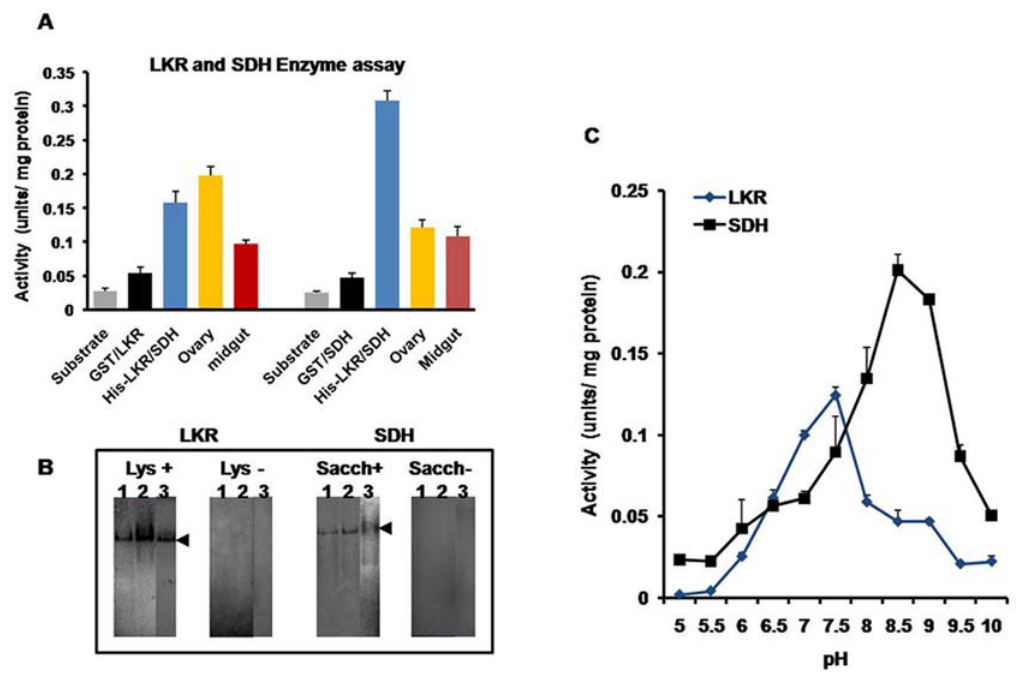
Figure 4. Enzymatic activity assay. A. Native and recombinant proteins were analyzed for LKR and SDH activities under conditions of excess concentrations of all LKR substrates or all SDH substrates, respectively. Data are presented as units/mg protein. Mean 6 S.D (n=3). B. Separation of LKR and SDH activities by native-PAGE gel electrophoresis. Samples of partially purified midgut and ovaries, and recombinant His-LKR/SDH were separated by native PAGE and subsequently stained for SDH and LKR activity. In the control gel, samples incubated without L-lysine and saccharopine are labeled ‘‘Lys-’’ and ‘‘Sacch-’’. In the LKR and SDH activity staining gel, the samples are labeled ‘‘Lys + ’’ and ‘‘Sacch + ’’. Lane 1, midgut; lane 2, ovary; lane 3, His-LKR/SDH. C. Optimum pH of LKR/SDH native